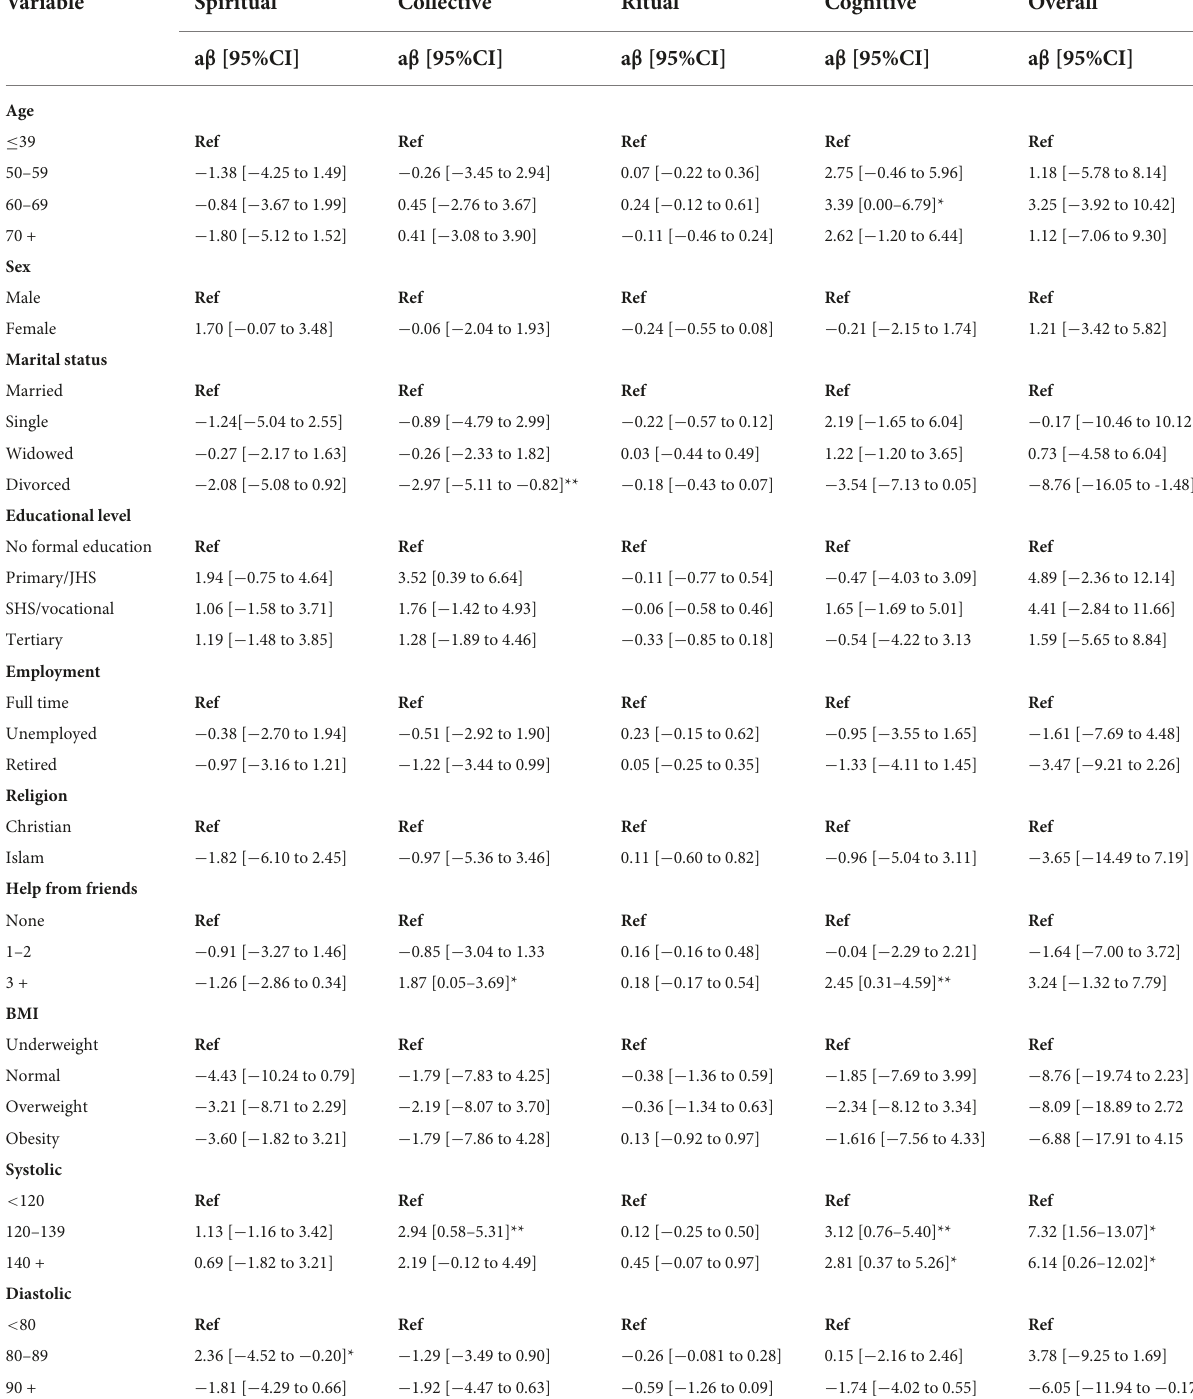
TABLE 2 Factors associated with overall coping strategies and the sub-domains among participants. Variable Spiritual Collective Ritual